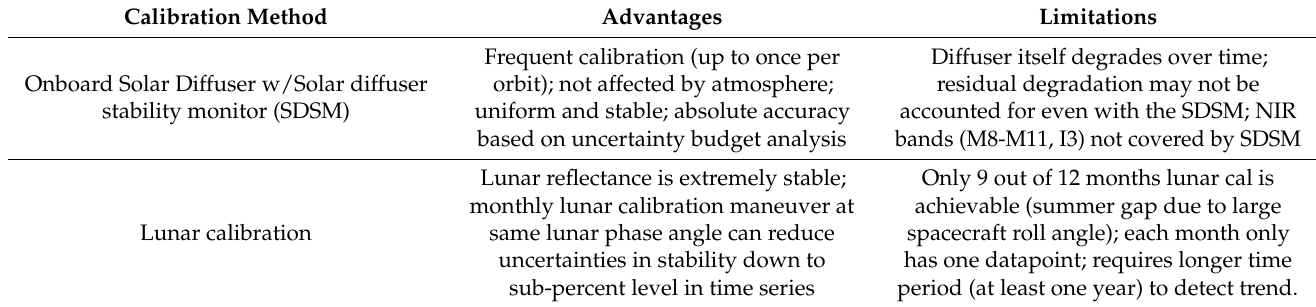
Table 2. Reflective Solar Band Calibration